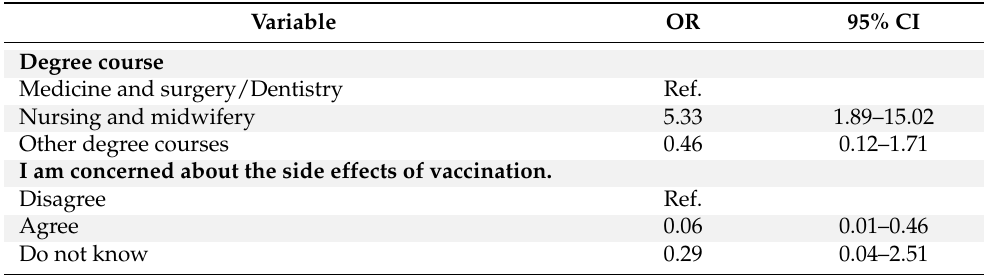
Table 6. Factors associated with adherence to the 2018–2019 flu vaccination campaign resulting from multiple logistic regression